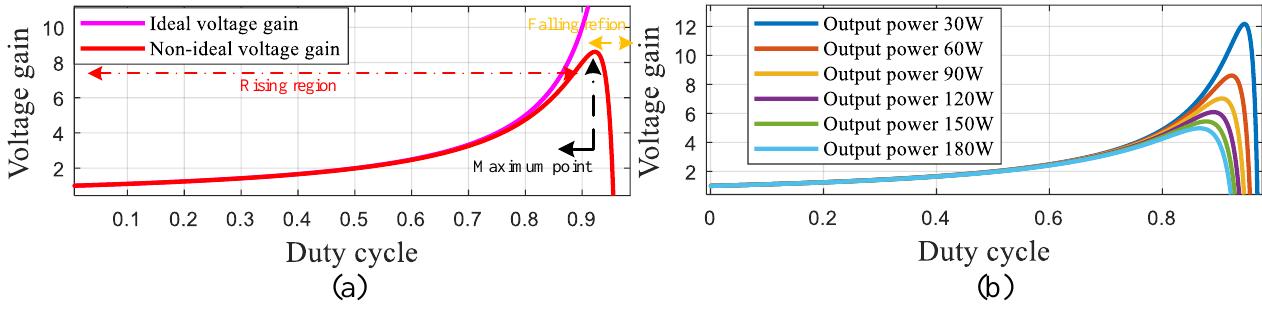
Figure 1. Ideal and non-ideal voltage gains of the boost converter: ( a ) limits of the boost converter’s voltage gain in non-ideal mode, ( b ) the behavior of the non-ideal voltage gain for different output